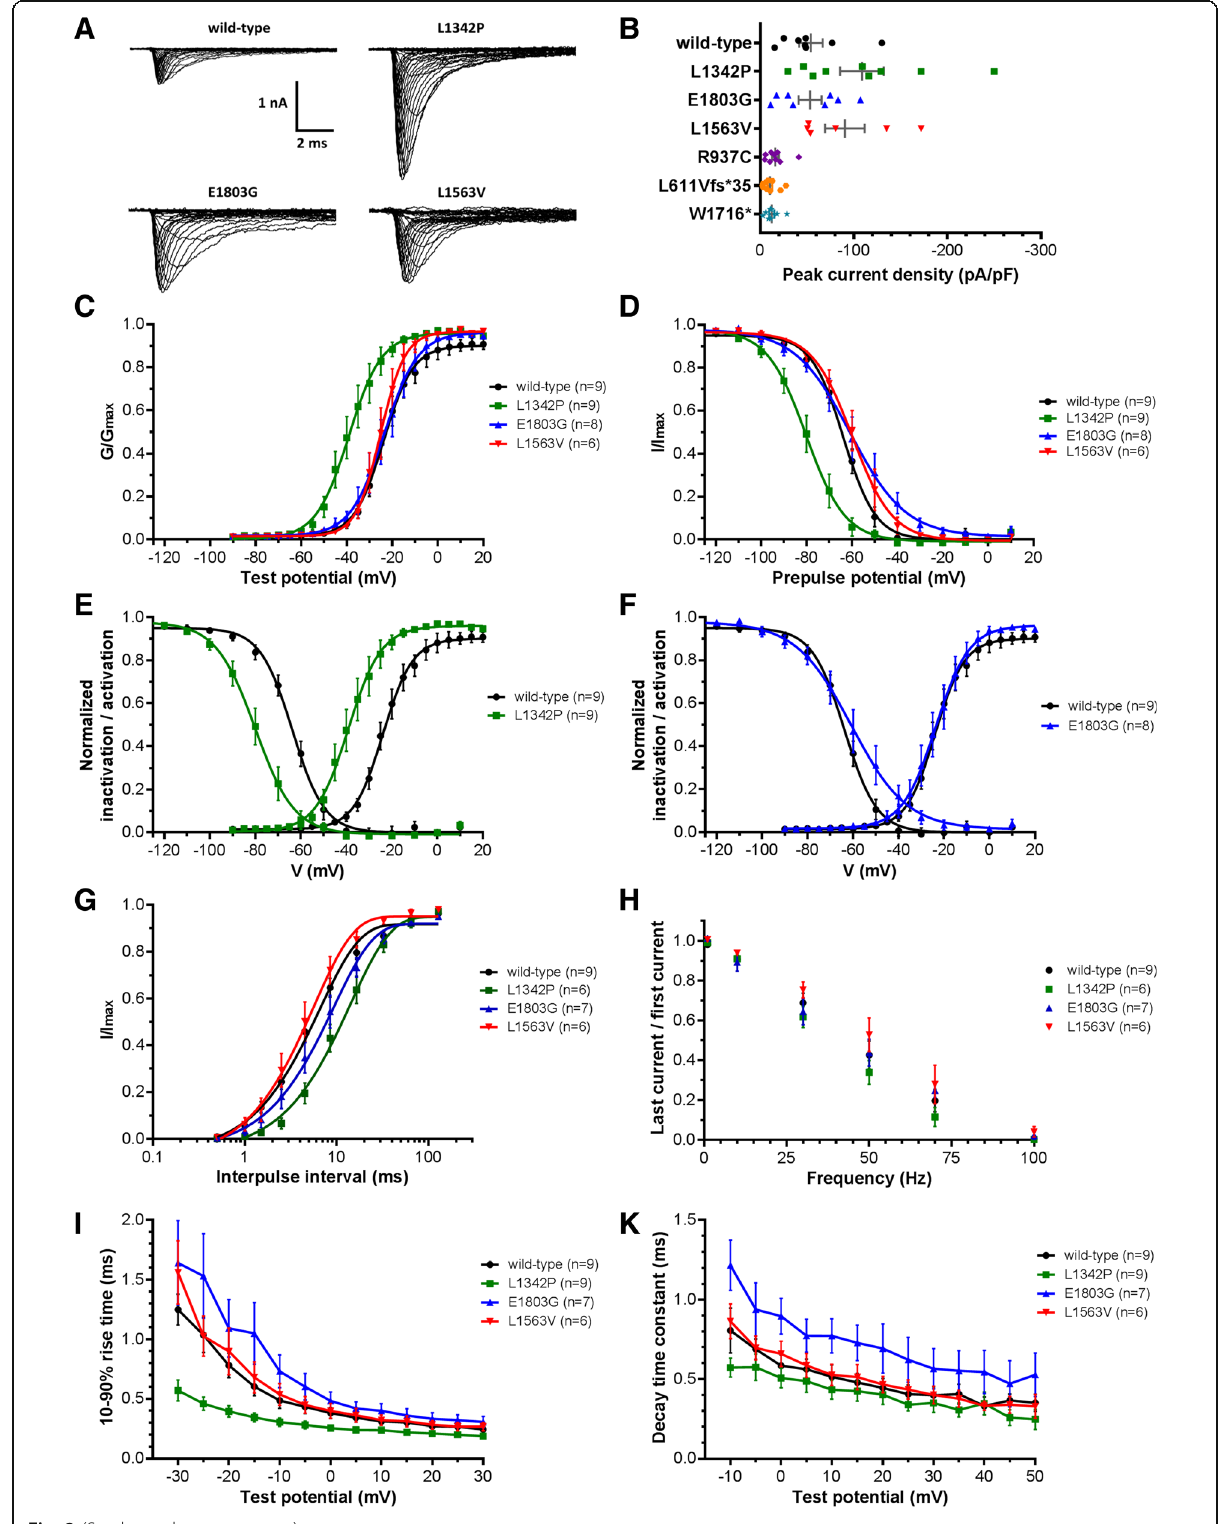
Fig. 2 (See legend on next